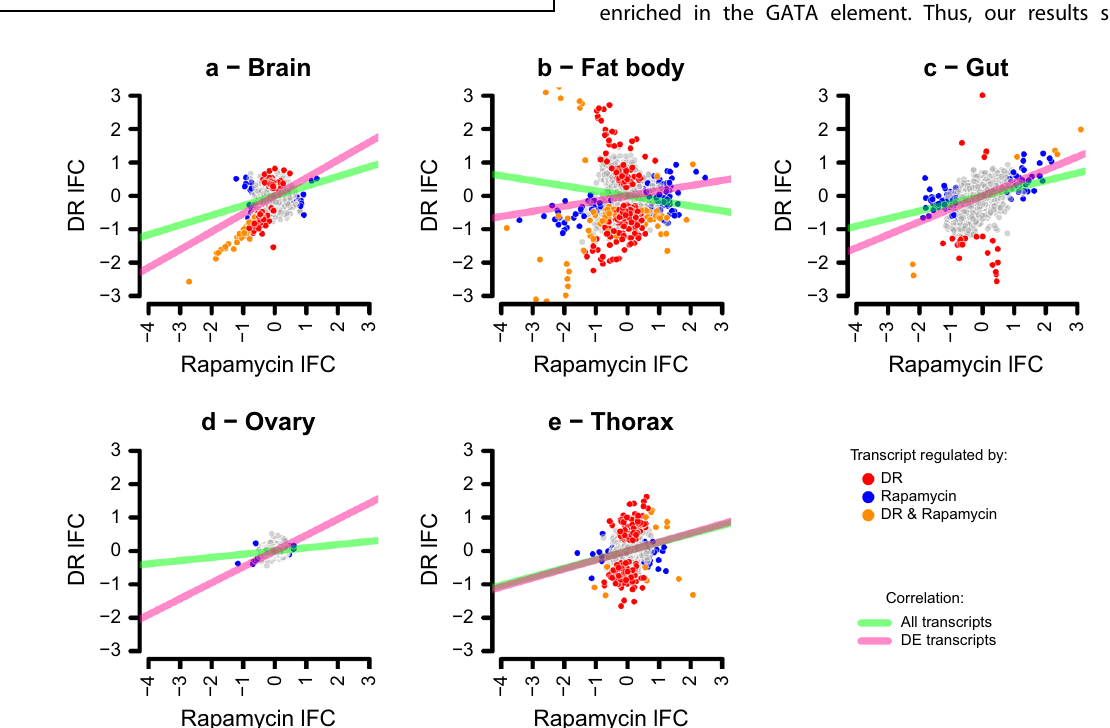
Fig. 2 Transcriptional effects of DR are consistent with reduced TOR signalling. Panels show log 2 fold-changes in expression (lFC) relative to the EAA-replete control in the DR and rapamycin-fed conditions for each tissue assessed (a - brain; b - fat body, c - gut, d - ovary and, e - thorax). Slopes of lines show correlation coef fi cients (Kendall ’ s Tau) for all genes in the transcriptome (green), or differentially expressed genes only (pink). All correlations were statistically signi fi cant ( p <